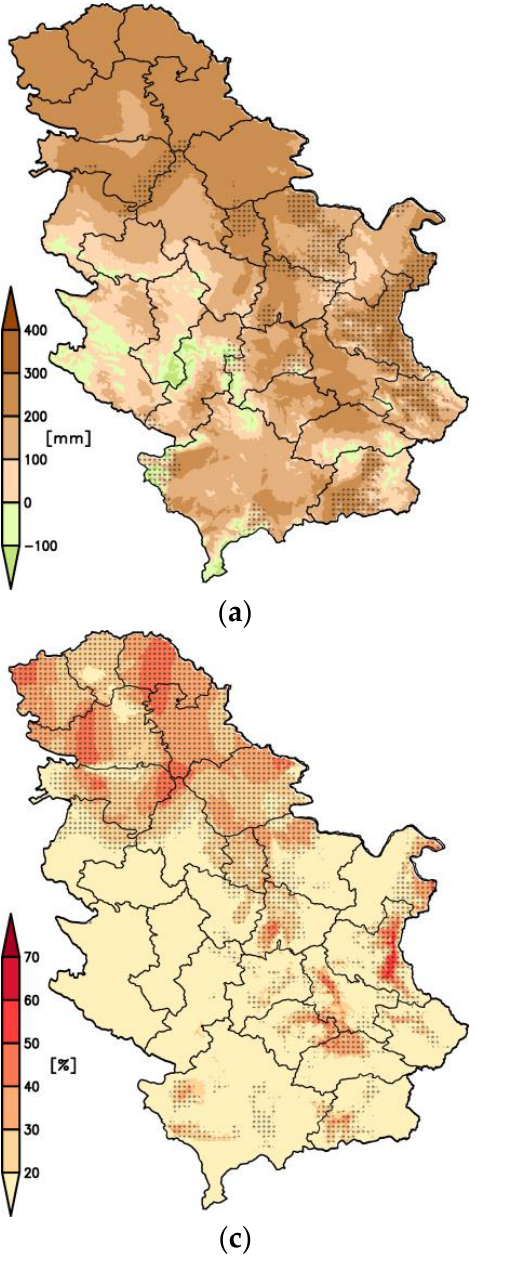
Figure 10. Upper row: average water deficit (mm) for different fruits in 1998 – 2017. Black dots mark areas where the change between the periods 1998 – 2017 and 1961 – 1990 was statistically significant. Lower row: frequency of years in which observed water deficit was larger than 300 mm in period 1998 – 2017. Black dots mark areas where the frequency has increased more than 10% between the periods 1998 – 2017 and 1961 – 1990. Results for berries ( a , c ), and grapes ( b , d ).